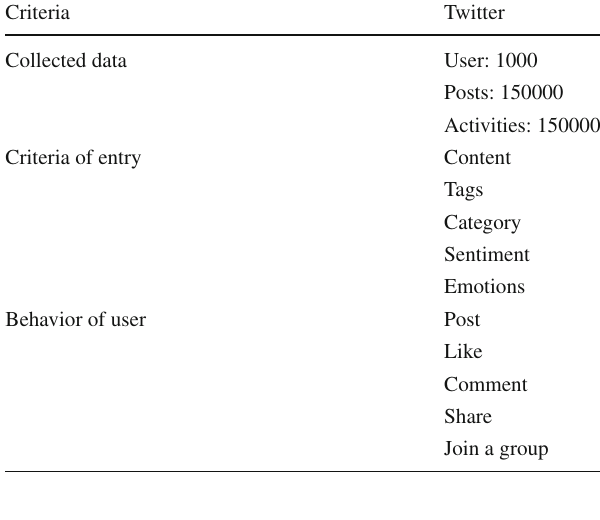
Table 2 Sample constructed from